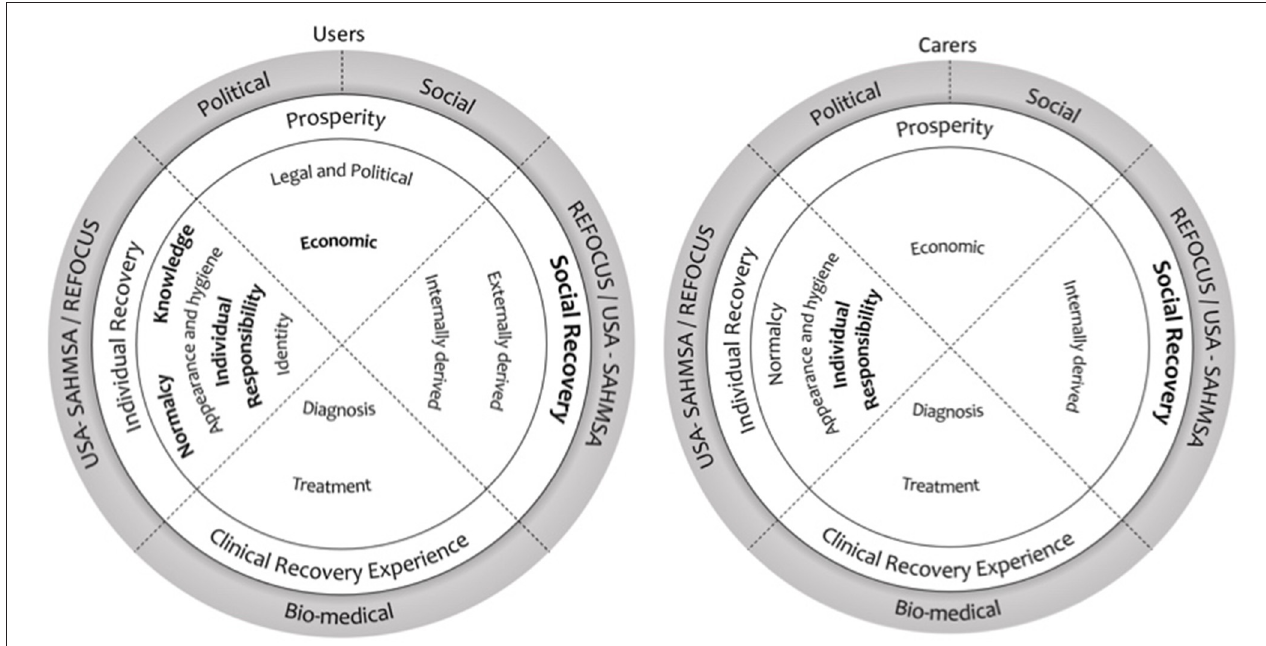
FIGURE 2 | Meta-synthesis map. Visual representation of how the recovery paradigms and themes identified in this systematic review are related and their predominance in user/carer samples. The circles on left and right represent recovery as understood by users and carers, respectively. The outer circle presents recovery paradigms, while the inner circles refer to the themes and subthemes. The most prevalent themes are highlighted in bold